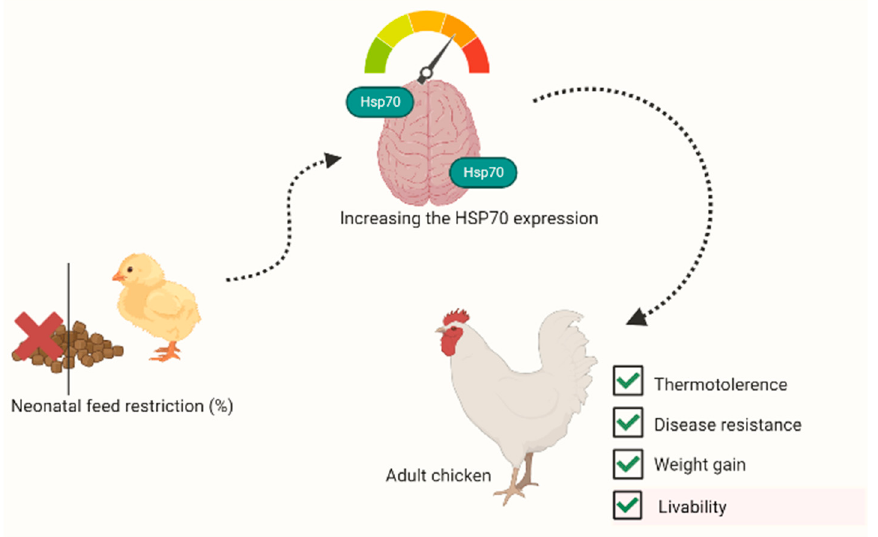
Figure 2. The benefits of feed restriction associated with HSP expression. (Created with BioRen- der.com).